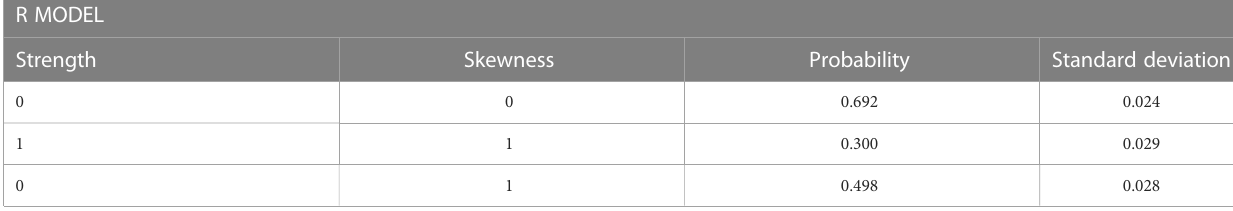
TABLE 5 Probabilities of longer-term class